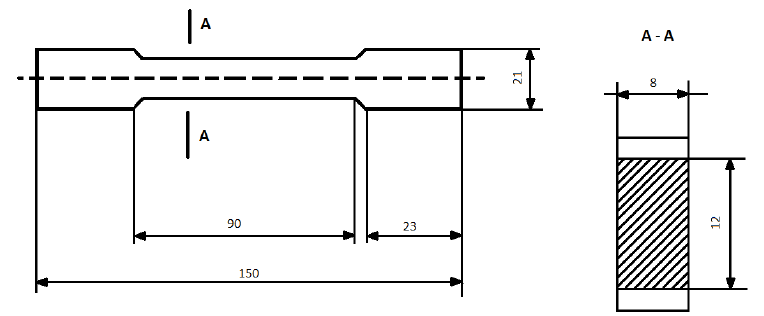
Figure 1. Dimensions (mm) and shape of the specimens of the cured epoxy